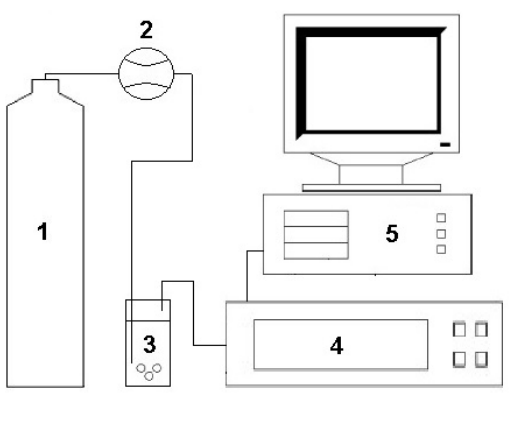
Figure 1. Experimental set-up for analysis of volatile fraction of agricultural distillates consisting of: 1—bottle with carrier gas; 2—flow meter; 3—scrubber; 4—prototype of electronic nose;